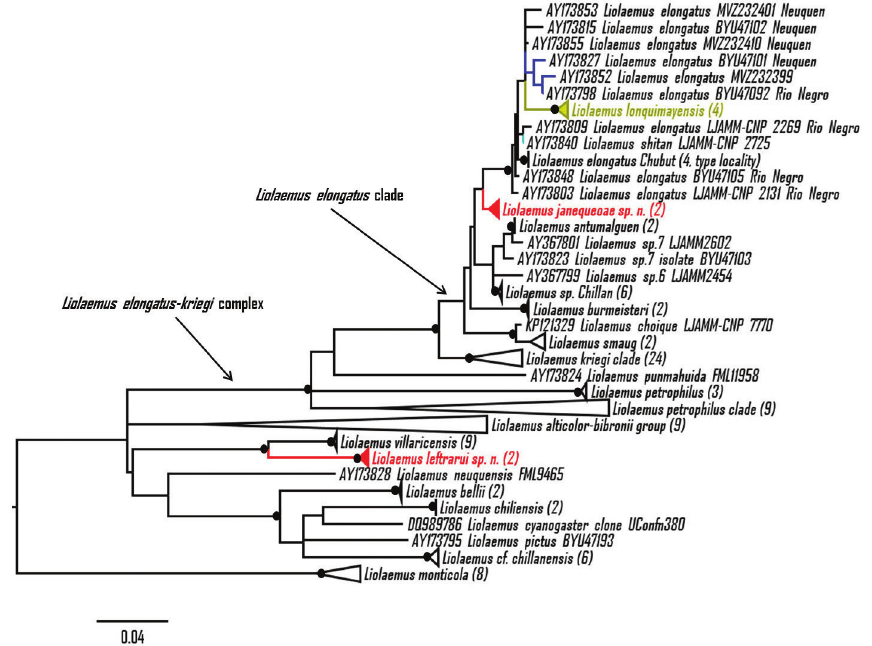
Figure 2. Maximum likelihood phylogeny (ML) tree based on Cyt-b , showing phylogenetic relationships of Liolaemus janequeoae sp. n. and L. leftrarui sp. n. (in red) (HKY+G+I). Liolaemus shitan is in light green, L. lonquimayensis is in yellow and L. elongatus samples used by Escobar-Huerta et al. (2015) are in blue. Bootstrap value ≥ 95% are indicated with a black dot. Numbers in parentheses indicate the amount of collapsed sequences. Scale shows the number of changes per site.